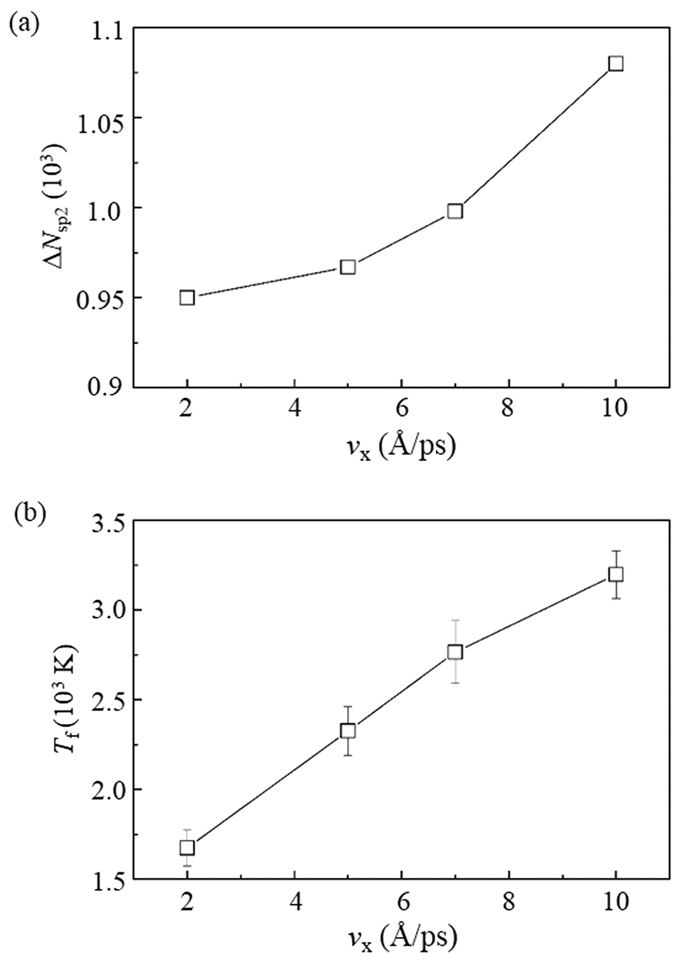
Effect of velocities vx of the DLC film on its (a) number of new sp2 atoms ΔNsp2 and (b) friction temperature Tf.